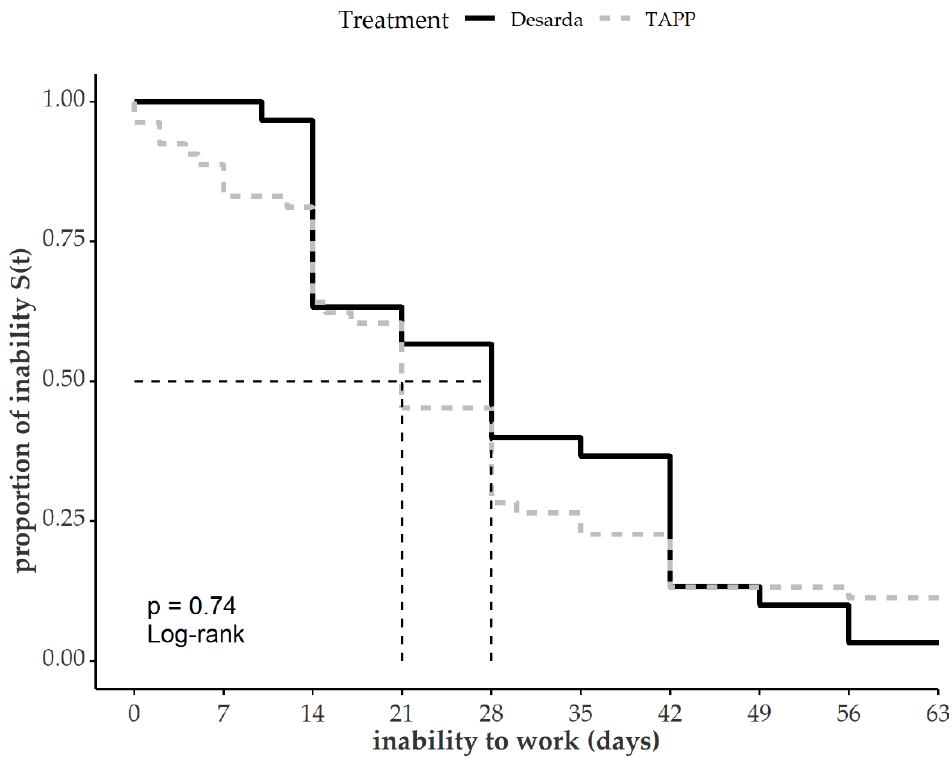
Figure 4. Self-reported time of inability to work after operation, n = 83 .